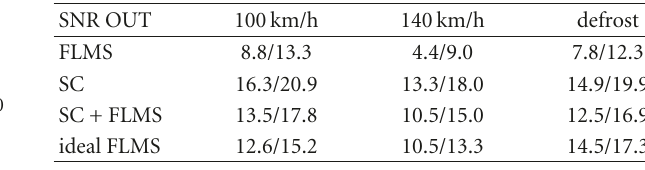
Table 3: Output SNR values [dB] for di ff erent combining tech- niques—short/tall speaker.